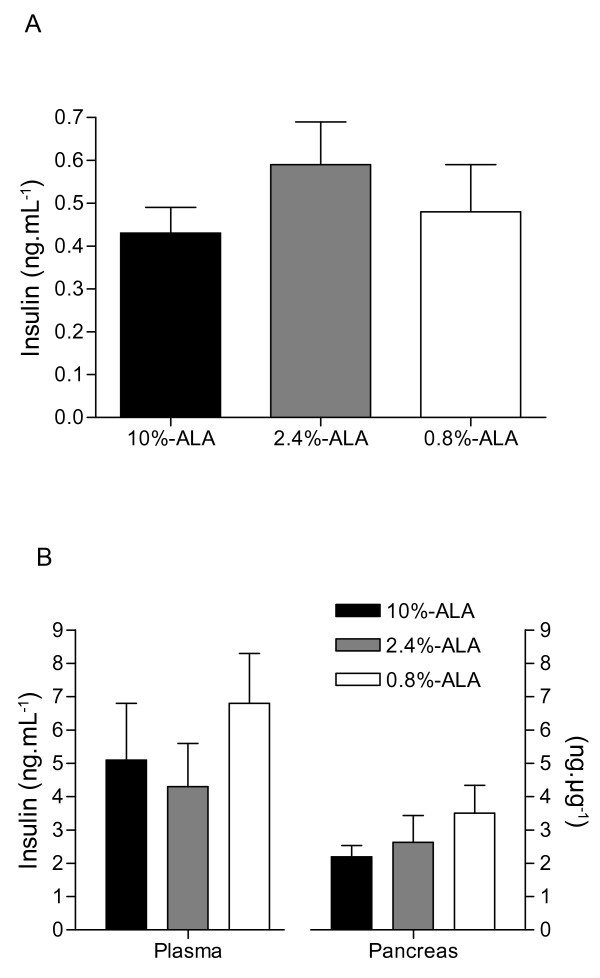
Plasma insulin concentrations and pancreatic insulin contents. (A) Plasma insulin at d21, n = 5 guinea pigs/group. (B) Plasma and pancreas insulin at d136, n = 10-15 guinea pigs/group. Data are medians ± SEmedian, no significant difference.